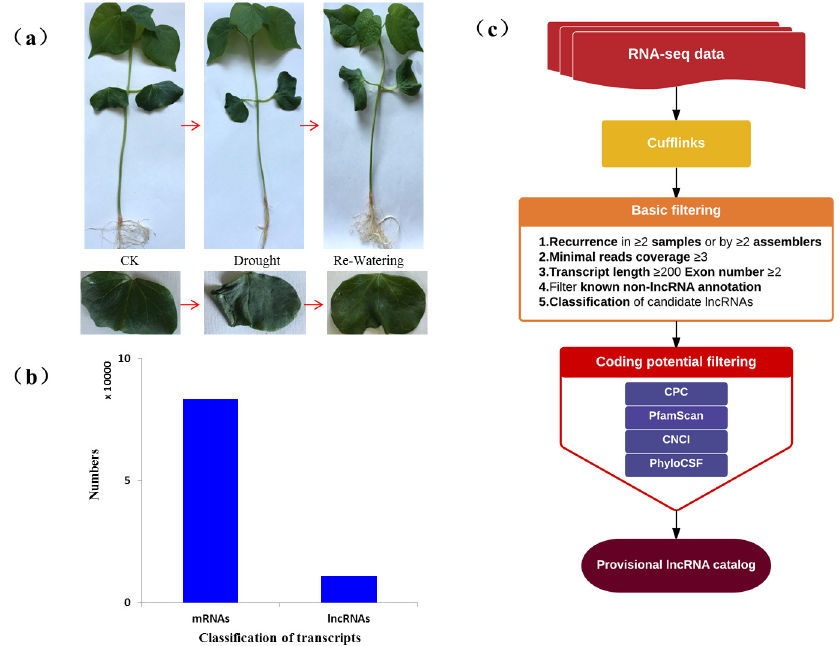
Fig 1. Morphological changes of seedlings after treatments and identification of long noncoding RNAs (lncRNAs). (a) Morphological changes of cotton seedlings after drought and re-watering treatments at trefoil stage. (b) The classification of transcripts by RNA-seq. (c) The Pipeline for the identification of lncRNAs in Gossypium hirsutum